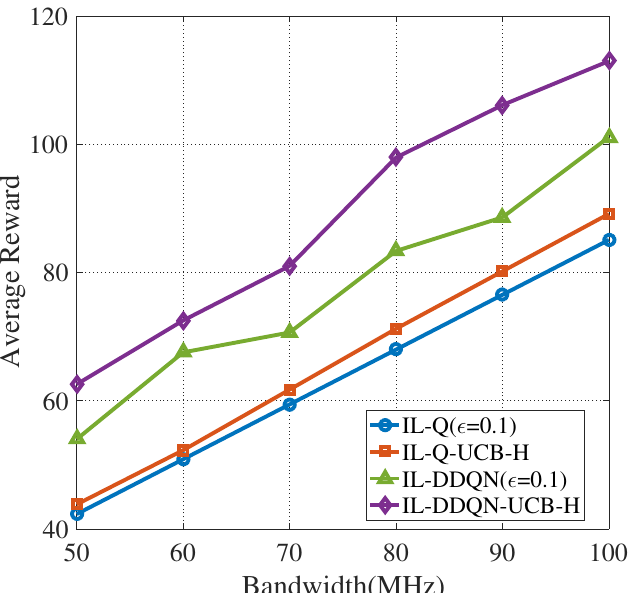
Figure 10. Evolution of the average reward of four algorithms with different bandwidths ( N = 4, M = 5).